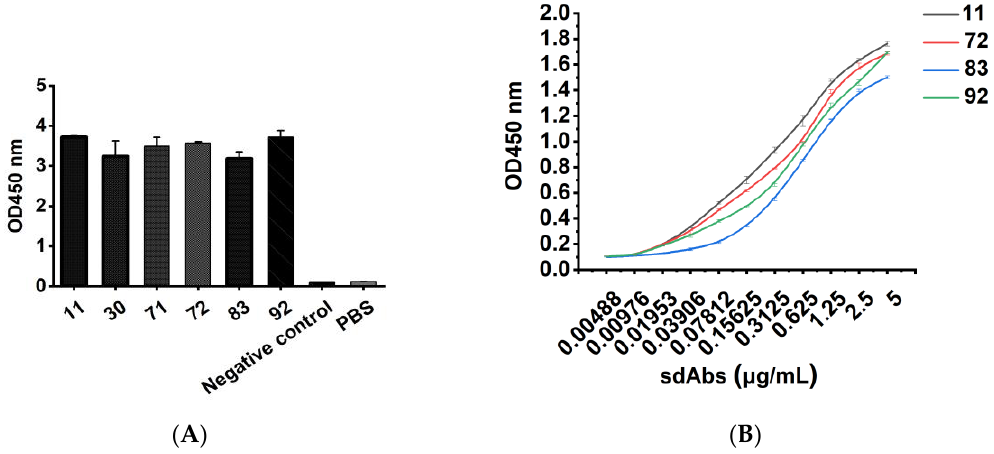
Figure 3. The binding activity of the purified recombinant sdAbs was detected by indirect ELISA. Recombinant sdAbs 11, 30, 31, 71, 72, 83, and 92 were added to CD20 extracellular peptide-coated microplates at a final concentration of 5 µ g/mL, and the binding of recombinant sdAb was detected by HRP-conjugated 6 × His-tagged mouse monoclonal antibody. The pET-25b-SBP empty vector-transformed bacterial lysate was used as a negative control, and PBS was used as a blank control ( A ). Recombinant sdAbs 11, 72, 83, and 92 were diluted from 5 µ g/mL to 0.00488 µ g/mL, and added to microtiter plates precoated with CD20 peptide, and the binding of recombinant sdAbs was detected with HRP-conjugated 6 × His-labeled mouse monoclonal antibody ( B ).